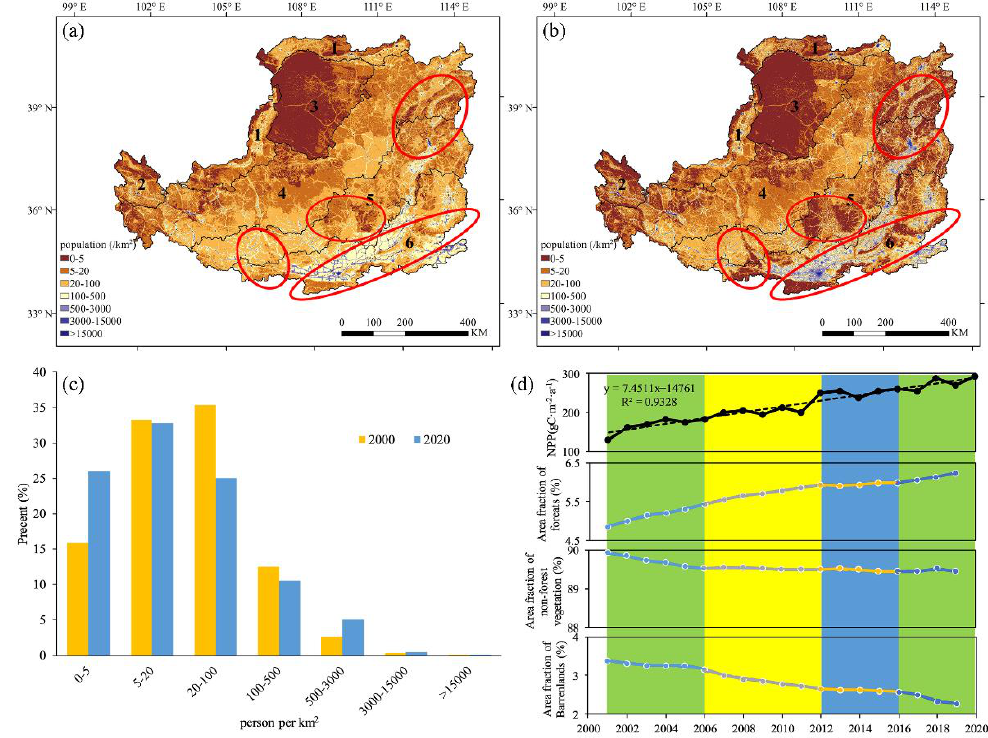
Figure 8. Human activity on the LP over the past 20 years. Panels ( a ) and ( b ) are maps of population density on the LP in 2000 and 2020, respectively. Panel ( c ) shows fractions of pixels for different population densities. Panel ( d ) represents variations in NPP with percentage area of forests, non- forest vegetation, and barren land on the LP. The red ellipses in panel ( a ) and ( b ) represent the regions with extreme decreases in population density. The color bars in panel ( d ) show the various stages of land use-managements.